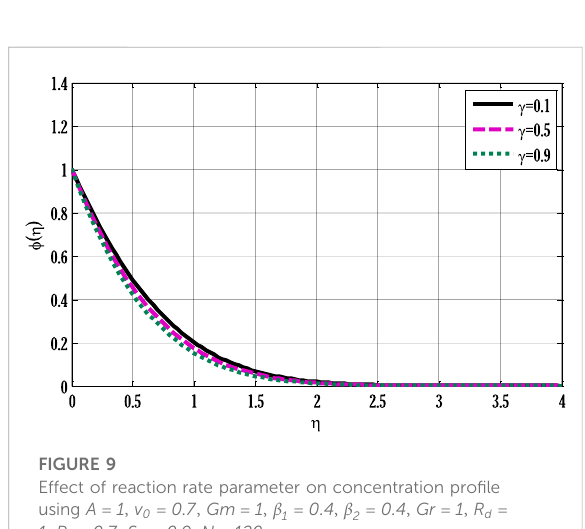
FIGURE 6 Effect of radiation parameter on temperature pro fi le using A (cid:1) 1 , v 0 (cid:1) 0 . 7 , Gm (cid:1) 1 , β (cid:1) 0 . 4 , β (cid:1) 0 . 4 , P r (cid:1) 0 . 7 , Gr (cid:1) 1 , S c (cid:1) 1 2 0 . 9 , γ (cid:1) 0 . 7 , N (cid:1) 120 .